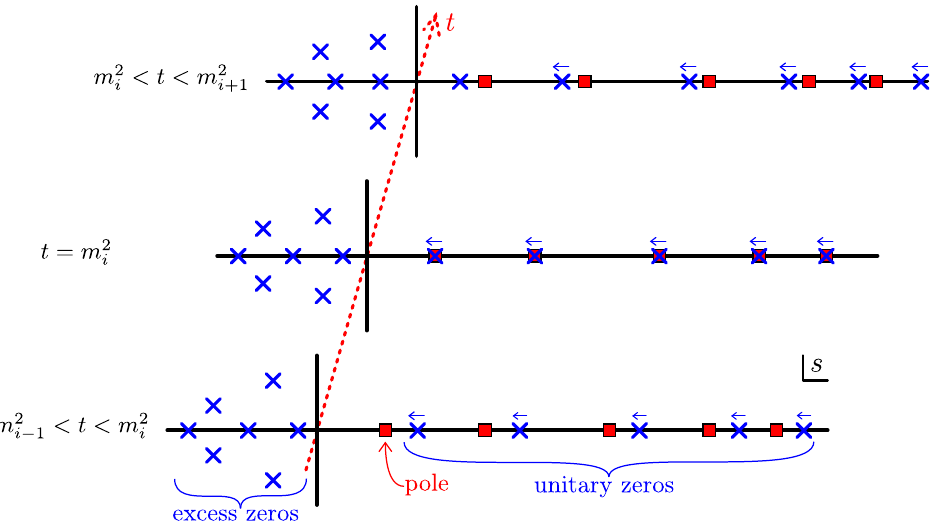
Figure 2 . Poles in s are represented by red boxes and zeros by blue crosses. The poles are fixed at the resonances while the zeros can move. At positive t we have one zero between any two successive poles (unitary zeros) plus a finite set of so-called excess zeros. As we increase t , the unitary zeros flow to the left. When t hits a resonance, there is a zero in s at exactly the points where there is a pole in s , so that they cancel each other and we remain with a polynomial. As t cross m 2 i , one unitary zero becomes an excess zero and so the number of excess zeros has grown by one, in agreement with